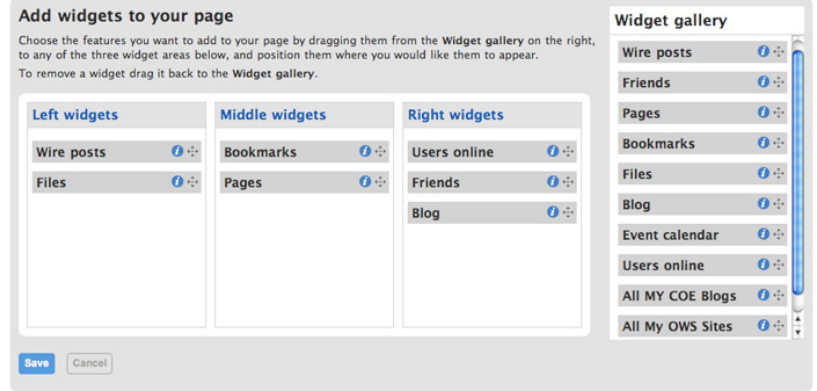
Figure 1 . A selection of features available in Elgg.